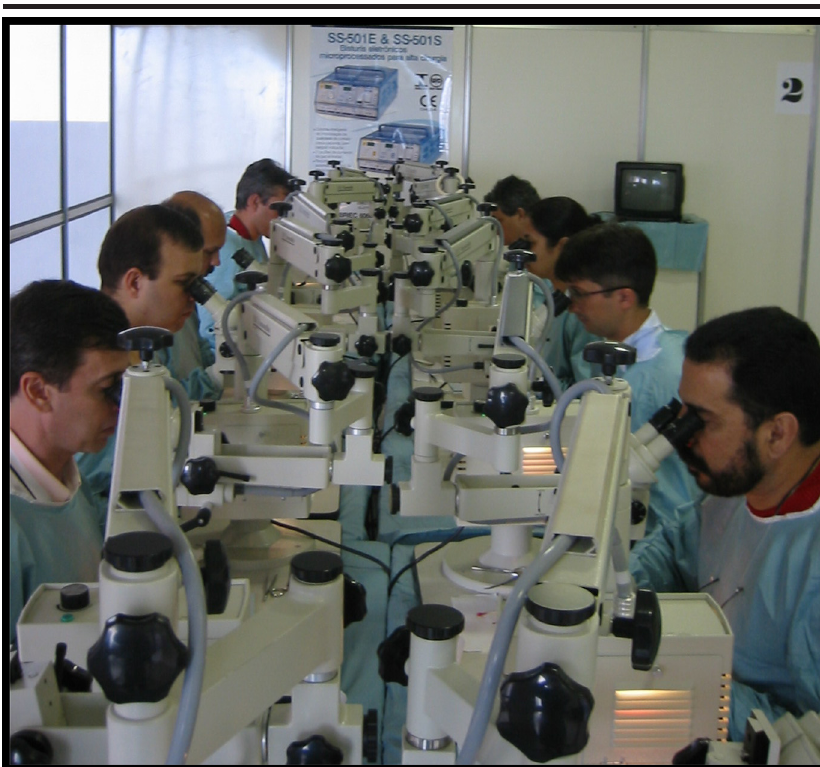
FIGURE 1 - Microsurgery course performed during the IX Congress of the Brazilian Transplant Society and IV Potuguese-Brazilian Transplant Congress, promoted by the Brazilian Transplant